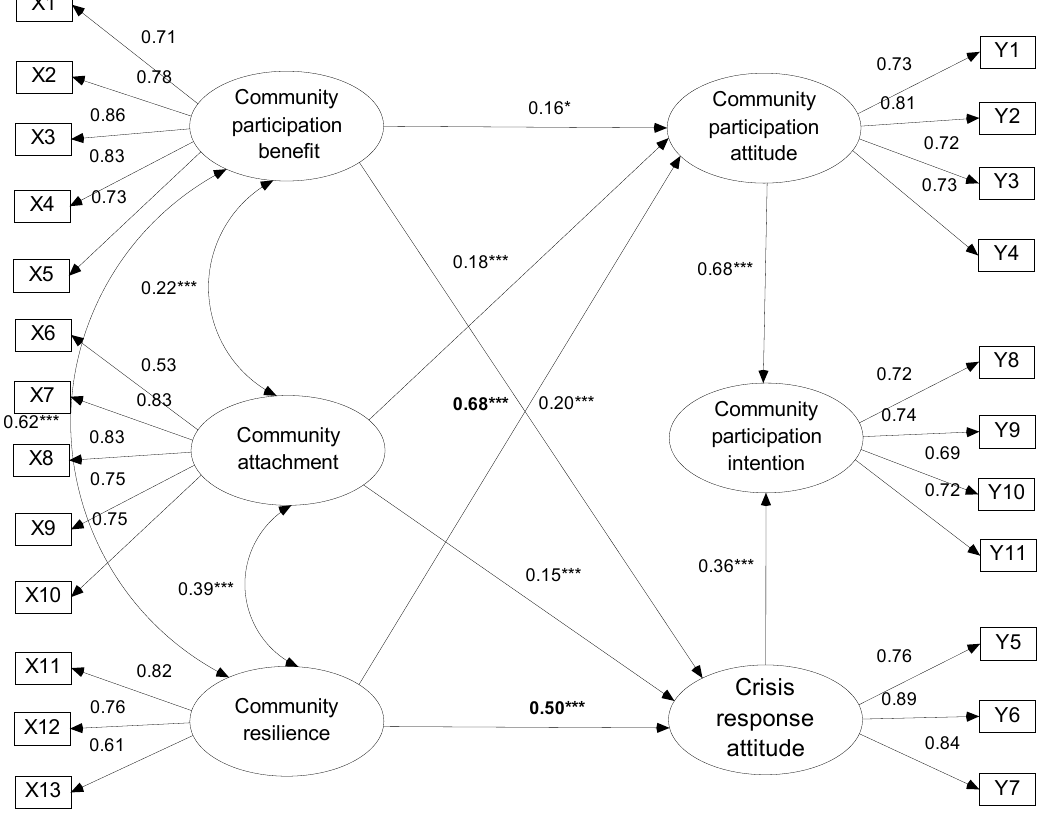
Figure 3. Results of structural model testing. ***Significance at the 0.001 level; *significance at the 0.01 level.